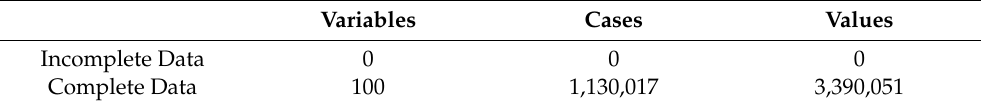
Table 2. Case processing summary (IBM SPSS).